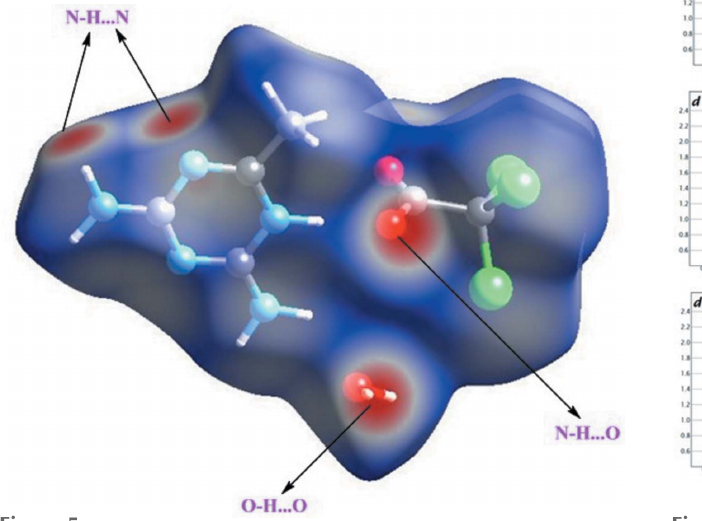
Figure 5 The three-dimensional Hirshfeld surface of the title